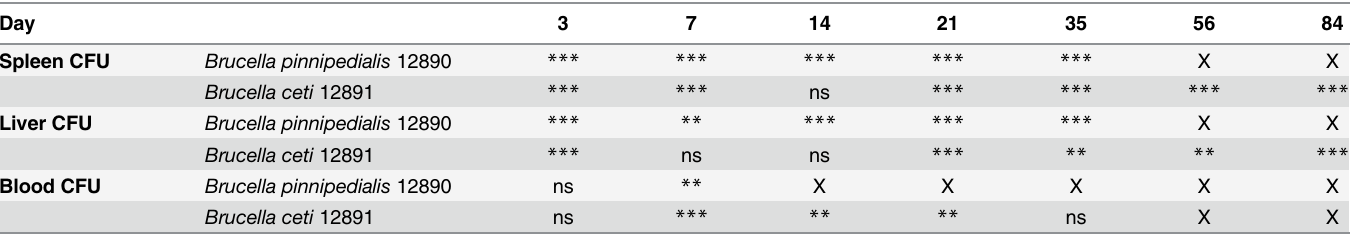
Level of statistical difference between the number of colony forming units (CFU) in spleen, liver and blood of BALB/c mice after intraperitoneal (ip) inoculation of 10 5 colony forming units (CFU) of B . suis 1330, B. pinnipedialis 12890 or B . ceti 12891. Four or fi ve mice were euthanized per lot at day 3, 7, 14, 21, 35, 56 and 84 post infection (day 56 and 84; only B . ceti 12891 and B . suis 1330). Mice infected with B . ceti 12891 or B . pinnipedialis are compared to mice infected with B . suis 1330 and *** = p < 0.001, ** = p < 0.01, * = p < 0.05, ns = not signi fi cant, X = not available.